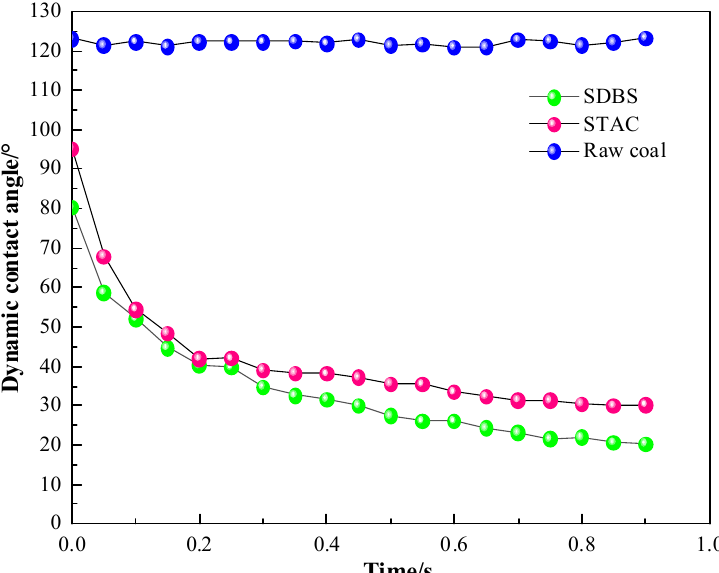
Figure 3. Dynamic change diagram of contact angle of surfactant and deionized water.